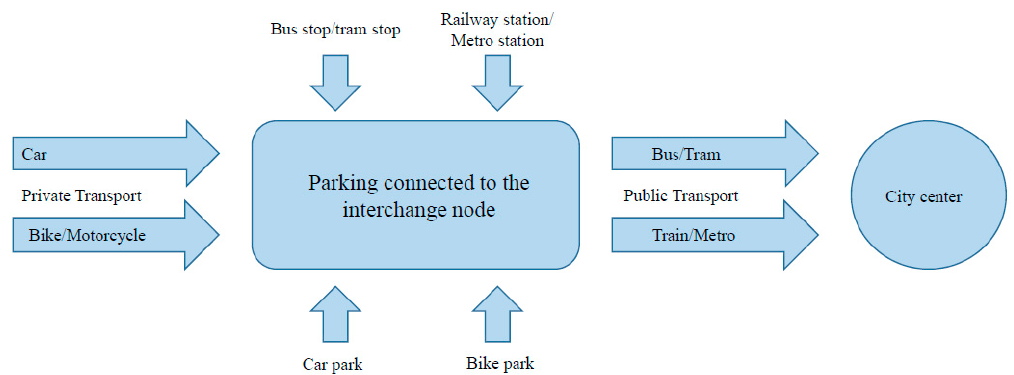
Figure 1. The idea of travels made using parking type P&R and various means of transport. Source : The authors, based on [1,3].